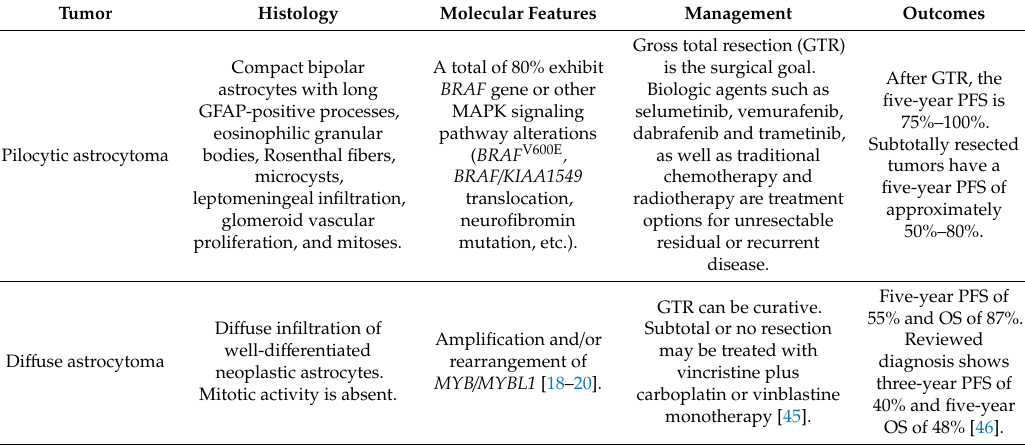
Table 2. Summary of histology, molecular features, management, and survival outcomes for select pediatric low-grade